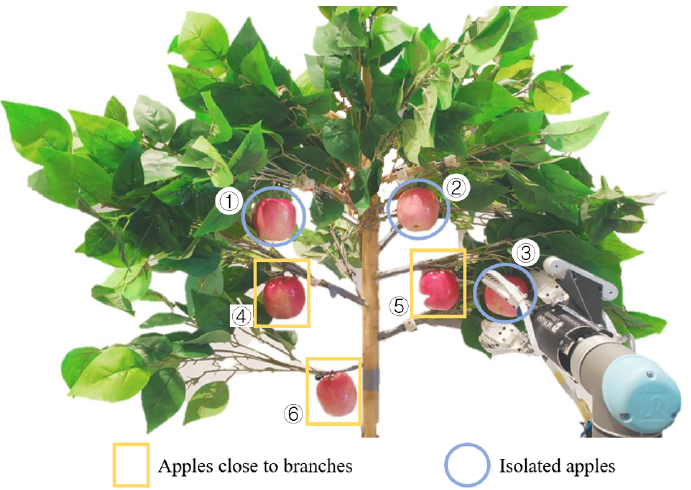
Figure 12. Artificial apple tree setting.